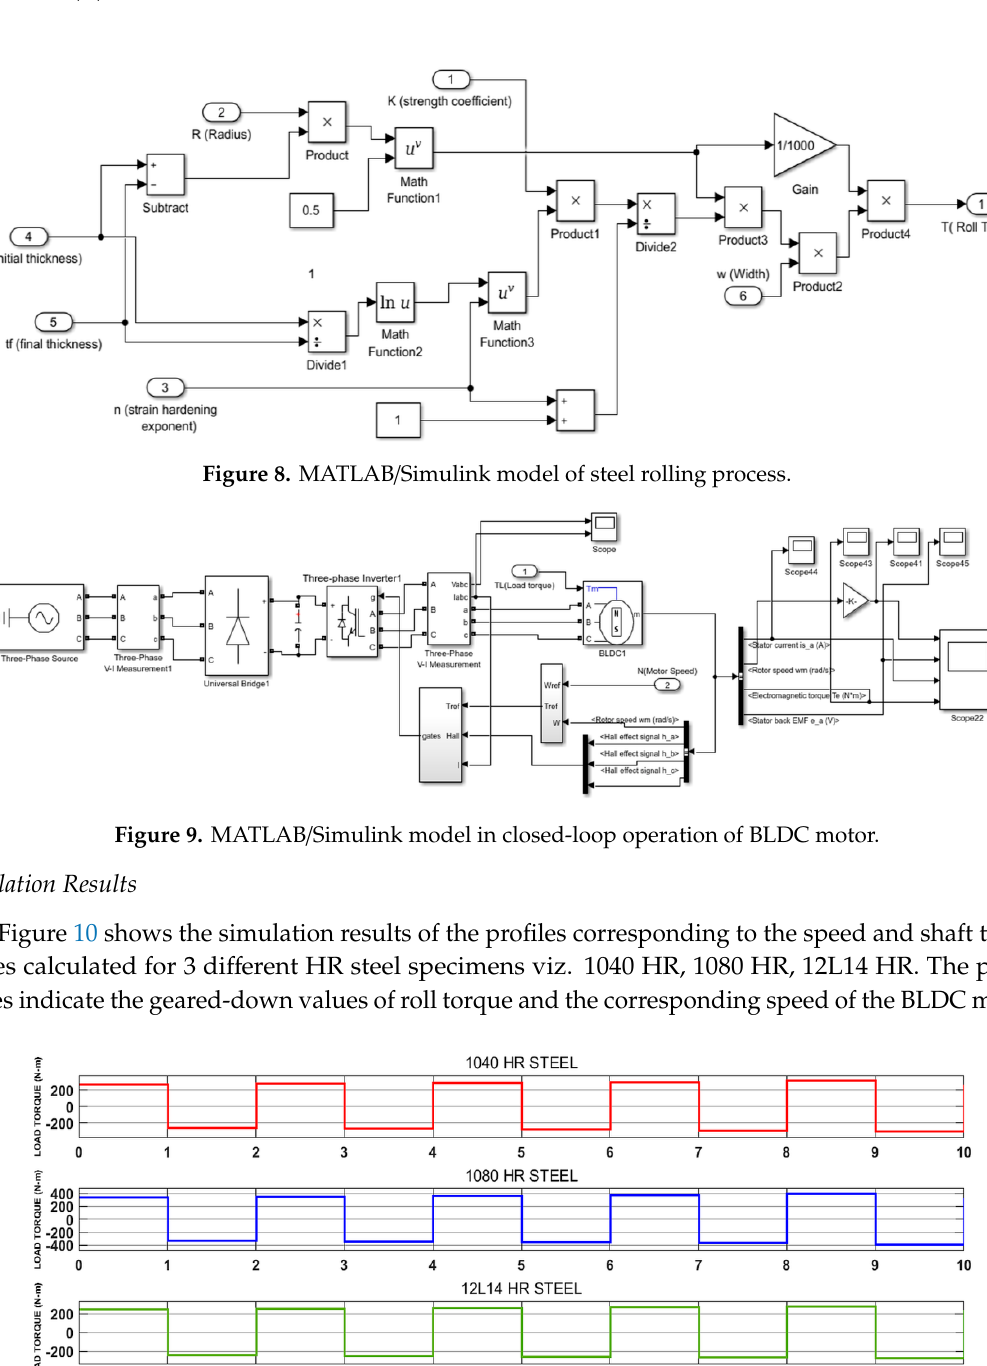
Figure 10. Speed and load torque demand at the work roll for 3 different HR steel.